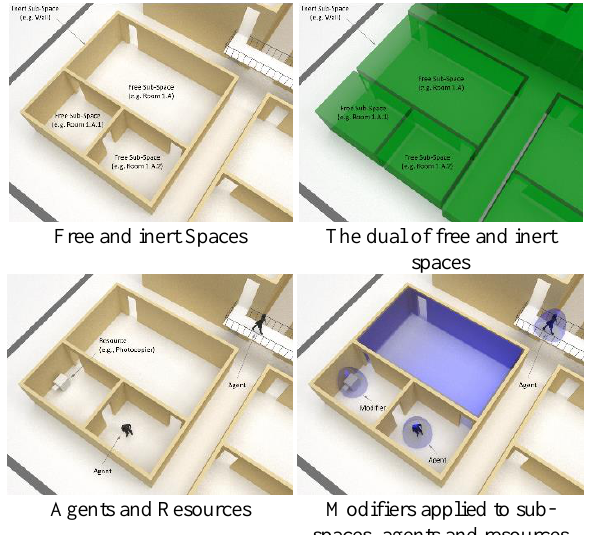
Figure 6. The proposed framework. Sub-spaces are divided into free and inert spaces. Sub-spaces are occupied by resources. Sub- spaces are also occupied by agents who perform activities in the sub-space or access resources. All sub-spaces, resources and agents possess the property ‘Placement’ that defines where the entity is in space.